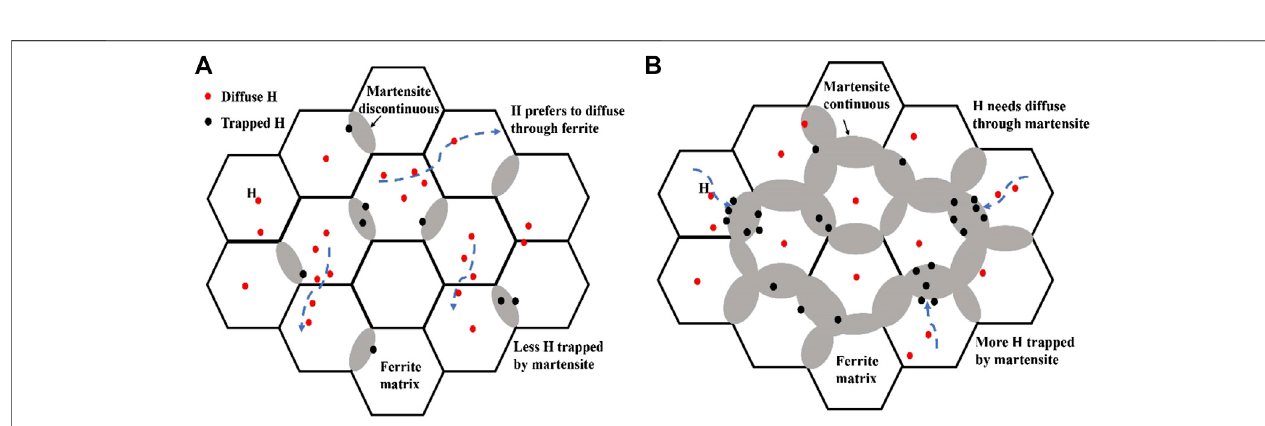
FIGURE13| Schematic representation ofthe microstructure-driven hydrogen diffusionin DPsteel: (A) distributionofmartensite isdiscontinuous; (B) ditributionof martensite is continuous.